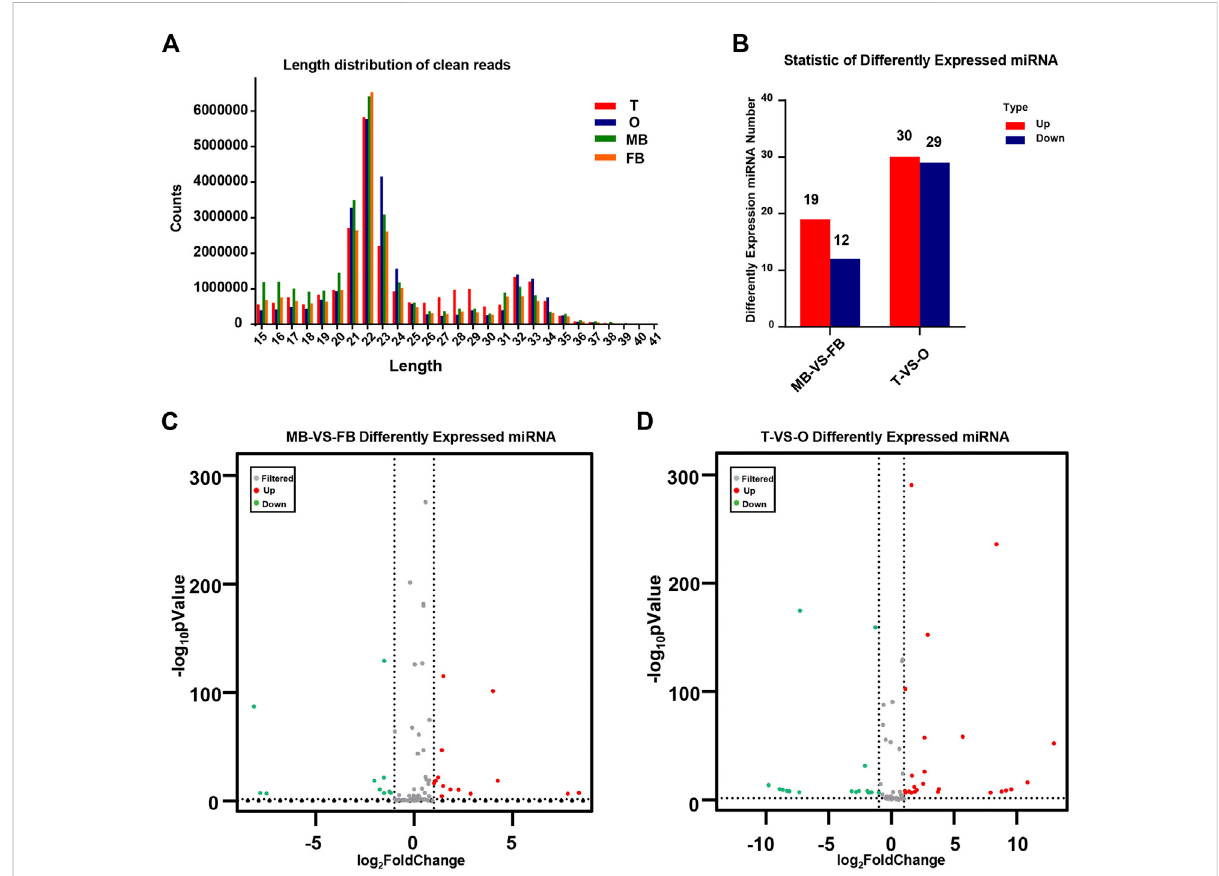
FIGURE 1 Identi fi cation of miRNAs. (A) The distribution of miRNA length from the M. rosenbergii. (B) Statistic of differently expressed miRNA. (C) Volcanic mapof M.rosenbergii differencesinthebrain. (D) Volcanicmapof M.rosenbergii differencesinthegonad.MB:malebrain;FB:femalebrain;T:testis; O: